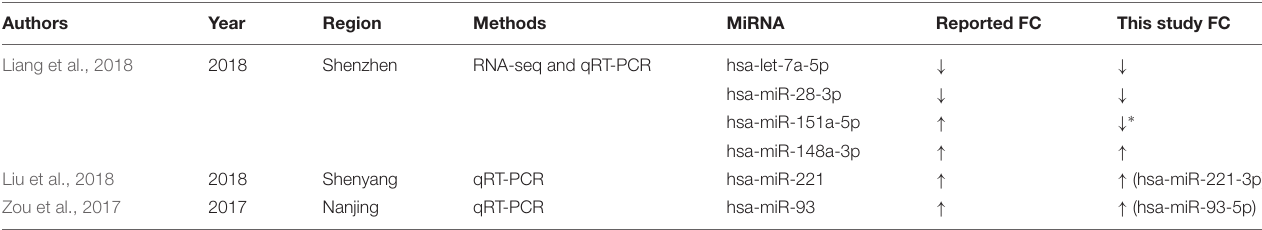
TABLE 3 | Significantly differentially expressed miRNAs in DR serum samples in Chinese T2DM patients in previous studies.